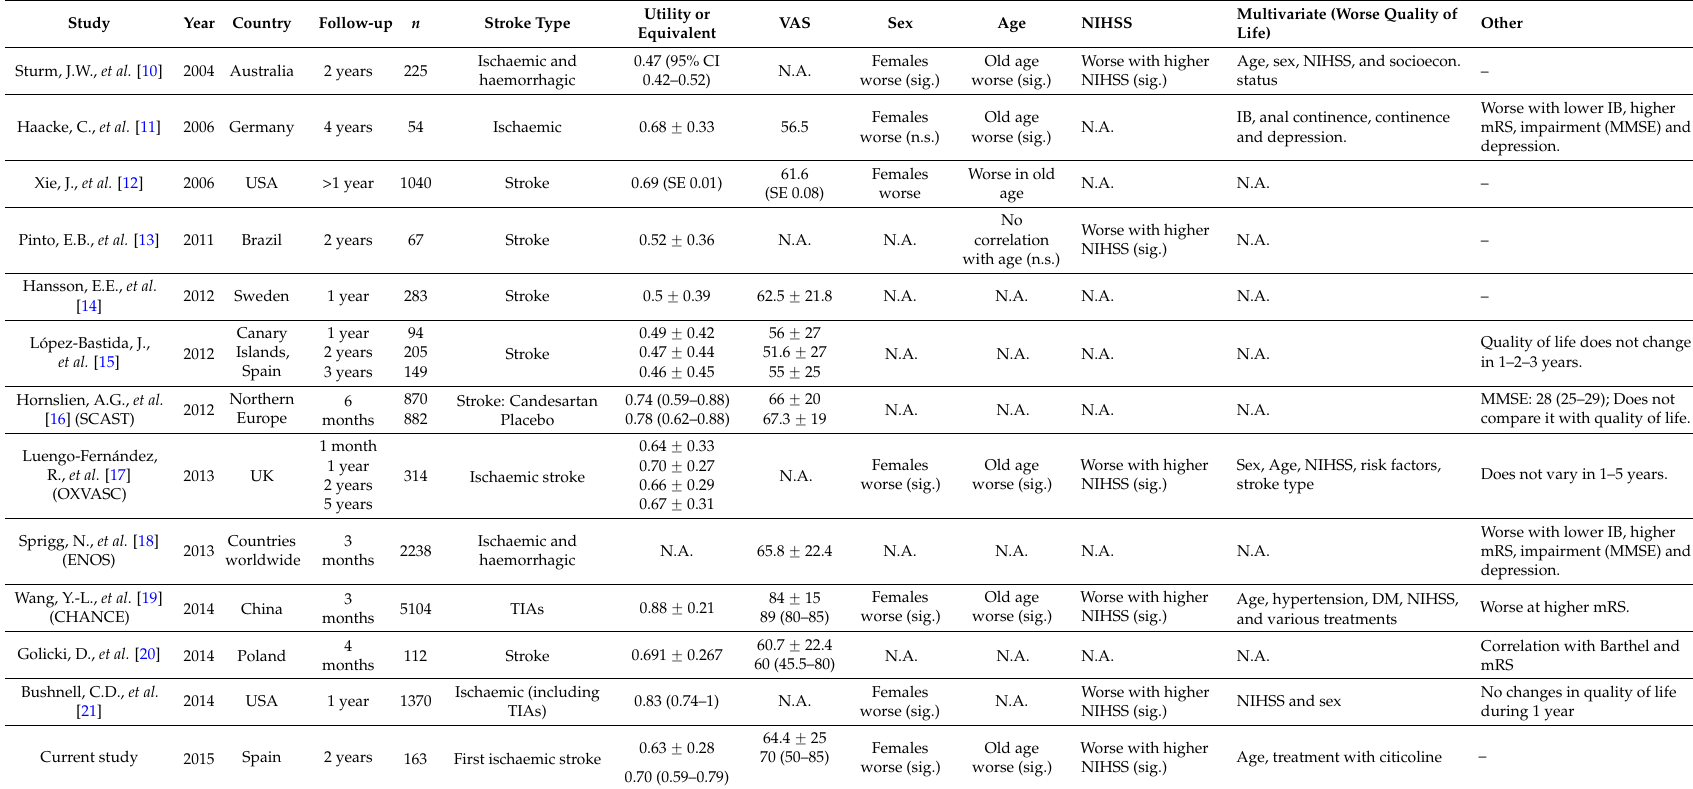
Table 4. Literature review of recent quality of life studies using the EuroQoL-5D scale in